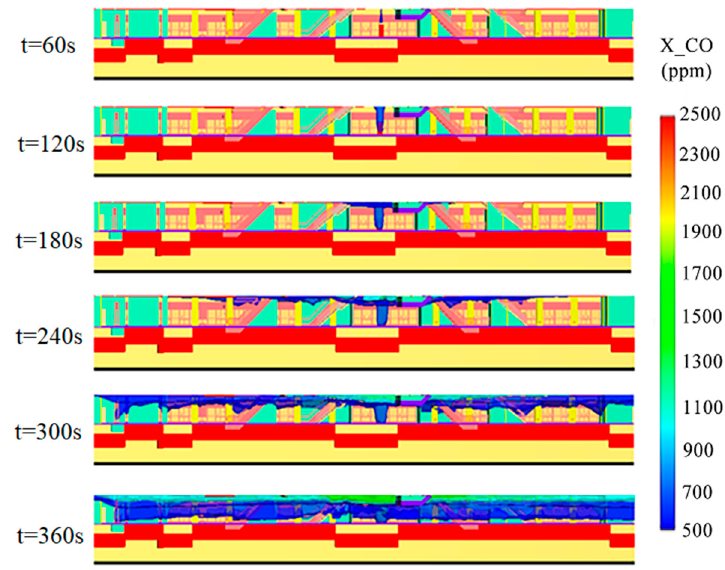
Figure 12. CO concentration of fire in the middle of the